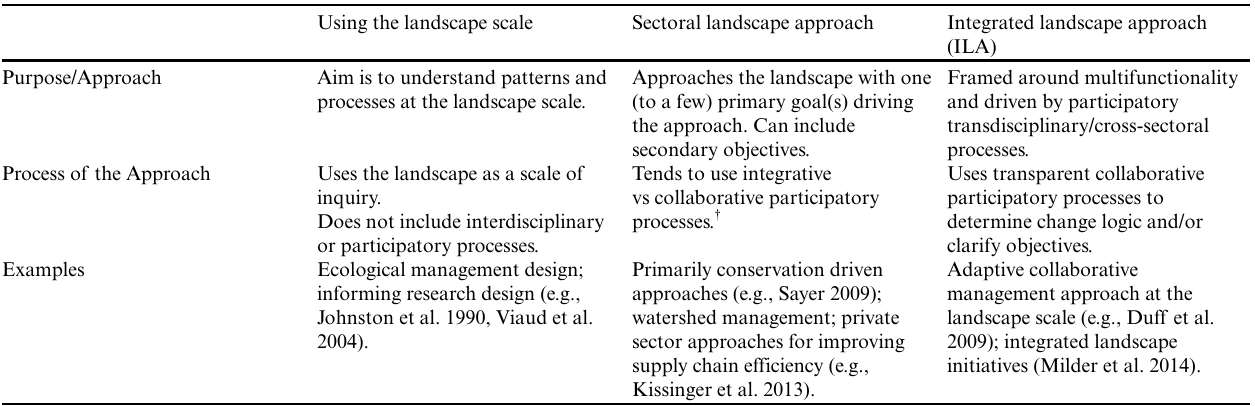
Table 1 . Three different kinds of landscape approaches. The focus in this paper is placed on the third, the integrated landscape approach